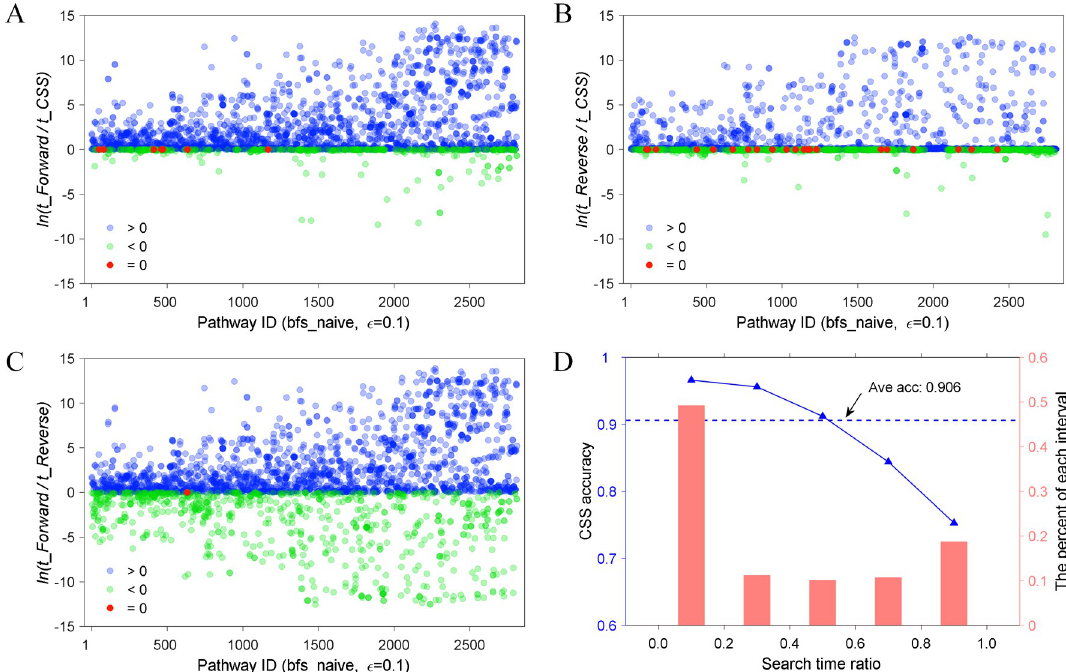
Fig 4. Comparative performance of time consumption on different search strategies. (A) The scatter plots of time consumption ratio of forward search divided by CSS based on LTIOD. (B) The scatter plots of time consumption ratio of reverse search divided by CSS based on LTIOD. (C) The scatter plots of time consumption ratio of forward search divided by that of reverse search. The horizontal and vertical axes of panels A, B and C are pathways ID and the natural logarithmic ratio of time consumption, respectively. The time consumption ratio is shown in natural logarithms. Blue, green and red dots represent ratio greater than, less than or equal to zero, respectively. Bfs_naive indicates breadth-first search method. (D) The accuracy and proportion distribution of LTIOD-based CSS on different intervals of search time